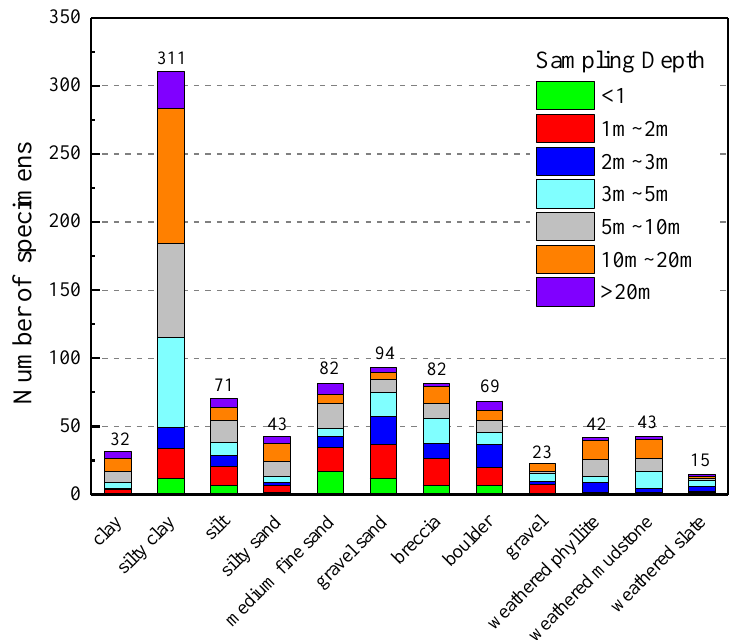
Figure 2. Statistic numbers of test samples for certain soil